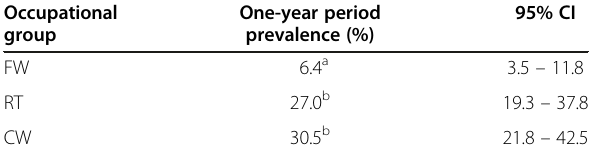
Table 6 Estimated one-year period prevalence of